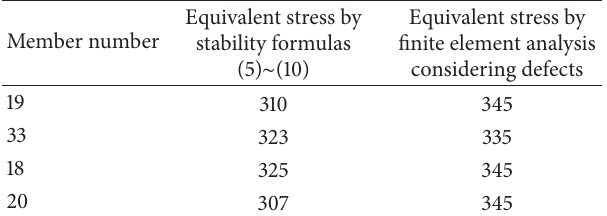
Table 2: Comparison between stability formulas and finite element analysis (positive load).